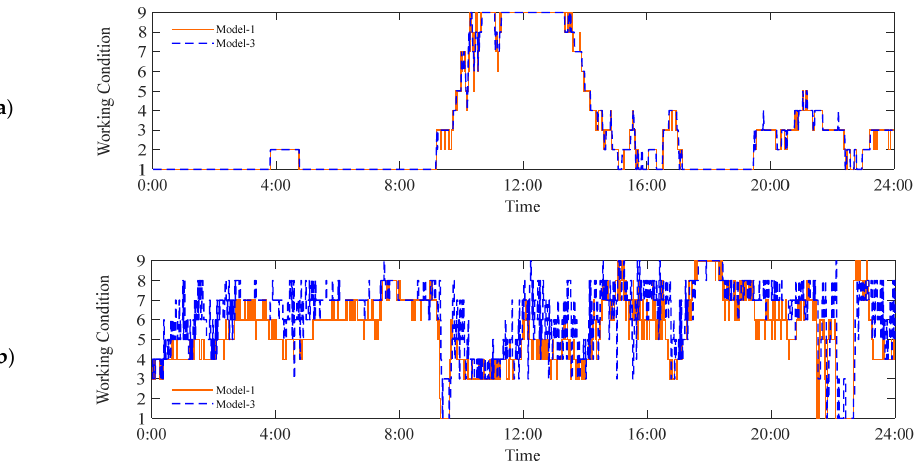
Figure 12. The comparison results of Model-3 and Model-1: ( a ) under normal operation state; ( b ) under abnormal operation state.